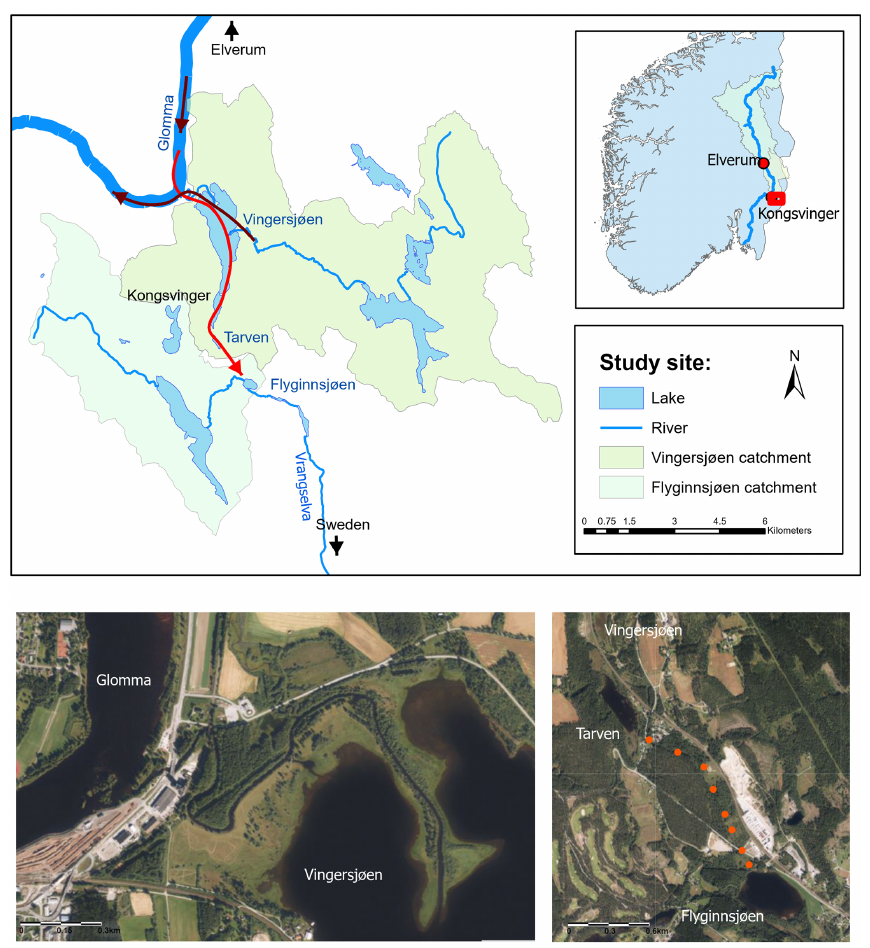
Figure 3. Study site for the paleodata. Map: the sediment cores were extracted from Lake Flyginnsjøen. The green arrows indicate the flow direction under normal conditions, whereas the dark red arrow shows the flow direction whenever there is a flood that exceeds 1500m 3 s − 1 and bifurcation occurs. Left areal photo: the river between Vingersjøen and Glomma. Under normal conditions the water flows from Vinger- sjøen into Glomma. Right areal photo: the flood path from Tarven to Flyginnsjøen during bifurcation events is indicated with red dots. Areal photo: © Norwegian Mapping Authority, Geovekst and the municipalities, Oslo-Østlandet